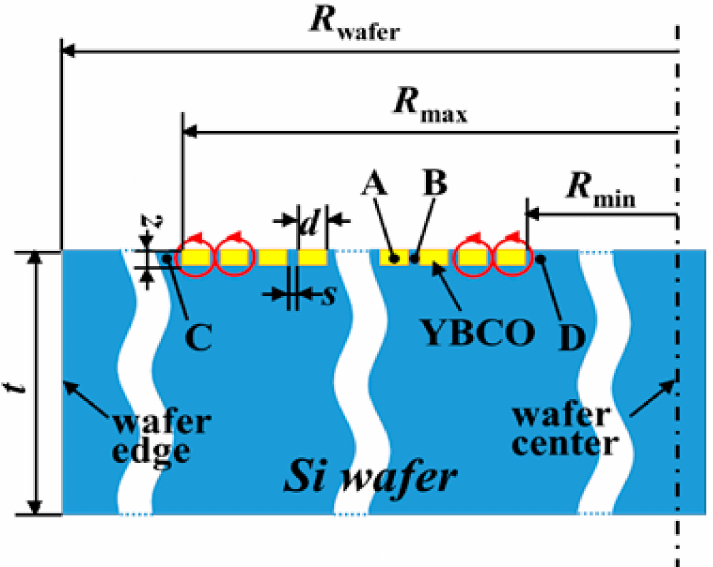
Figure 5. Schematic illustration of approximately one half of the cross-section of a wafer coil design in a Si wafer of 2 R wafer diameter and t thickness. Notations: d , s , z , R min , and R max stand for the trench width, the trench wall thickness, the trench depth, the radius of the inner wall of the innermost coil, and the radius of the outer wall of the outermost coil, respectively. The yellow rectangles indicate cross-sections of the trenches filled with